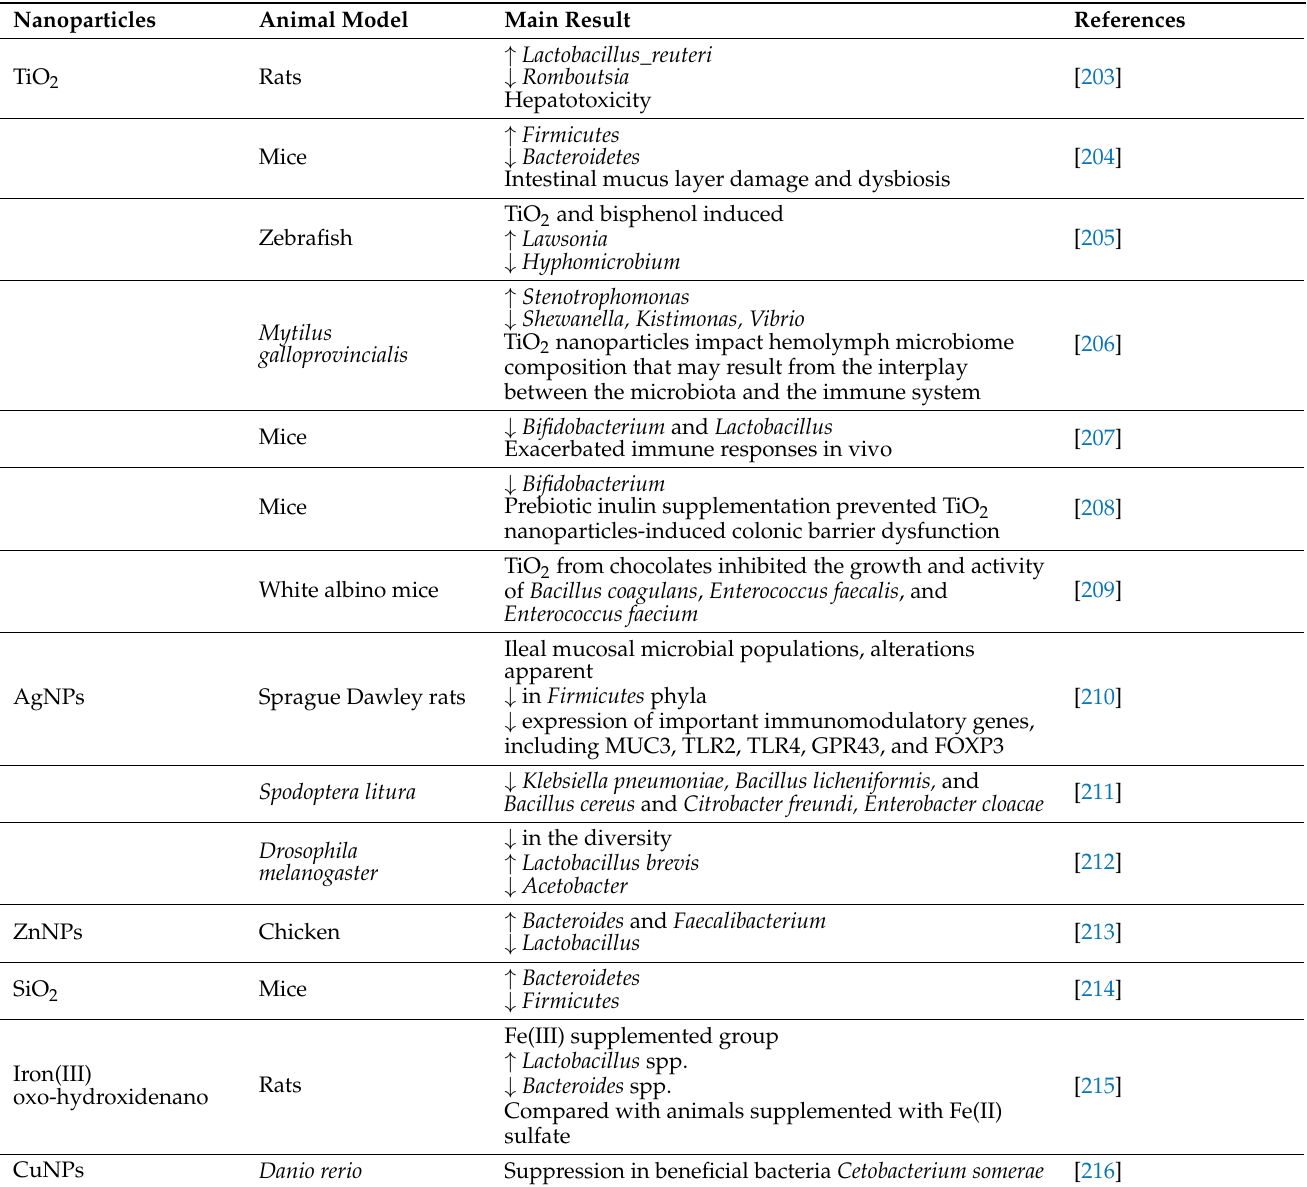
Table 3. Examples of some in vivo studies using nanoparticles to address their impact on the gut